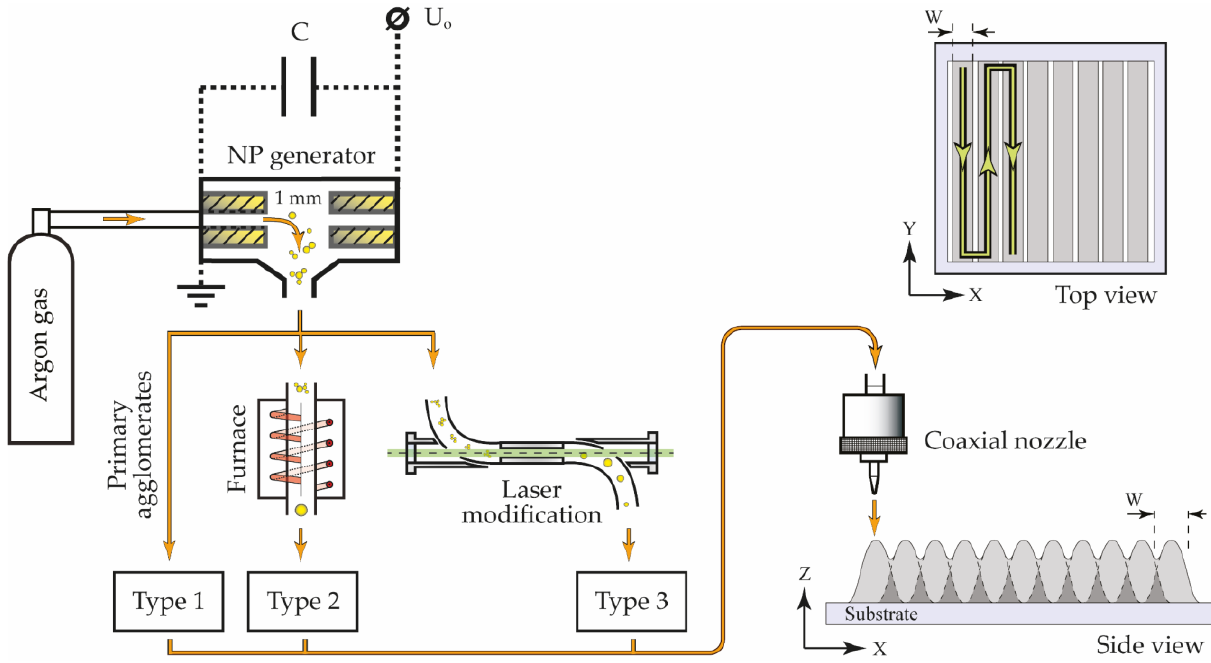
Figure 1. The scheme of the experimental setup with the SERS array printing pattern. The NPs morphology was characterized with a scanning electron microscope (SEM) JSM 7001F (JEOL, Ltd., Tokyo, Japan). SEM images were also used to determine the NPs’ surface density, the average size of modified NPs, and the percentage of individual NPs in the array by statistically processing 400 pieces on